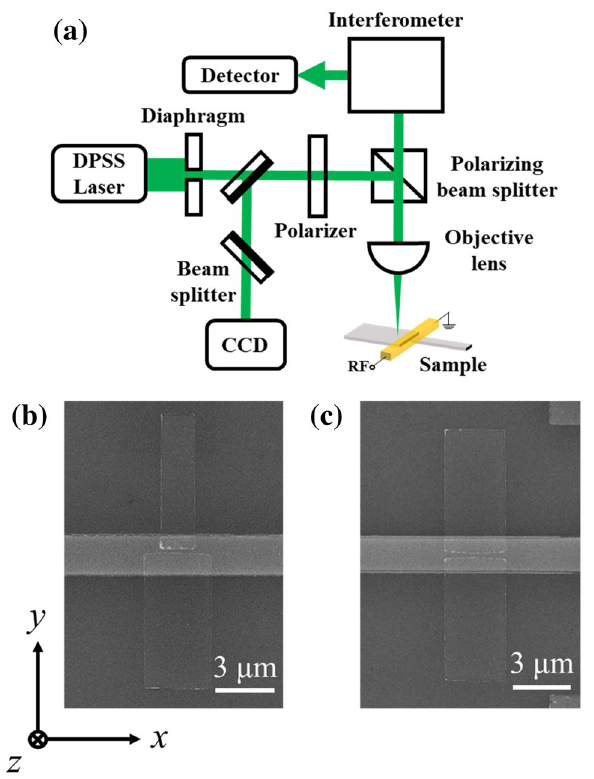
Figure 1. ( a ) Schematic diagram of the BLS measurement system. Scanning electron microscopy image of the magnetic blocks, separated by small gap and excitation antenna: ( b ) The two blocks have different widths. ( c ) The two blocks have identical